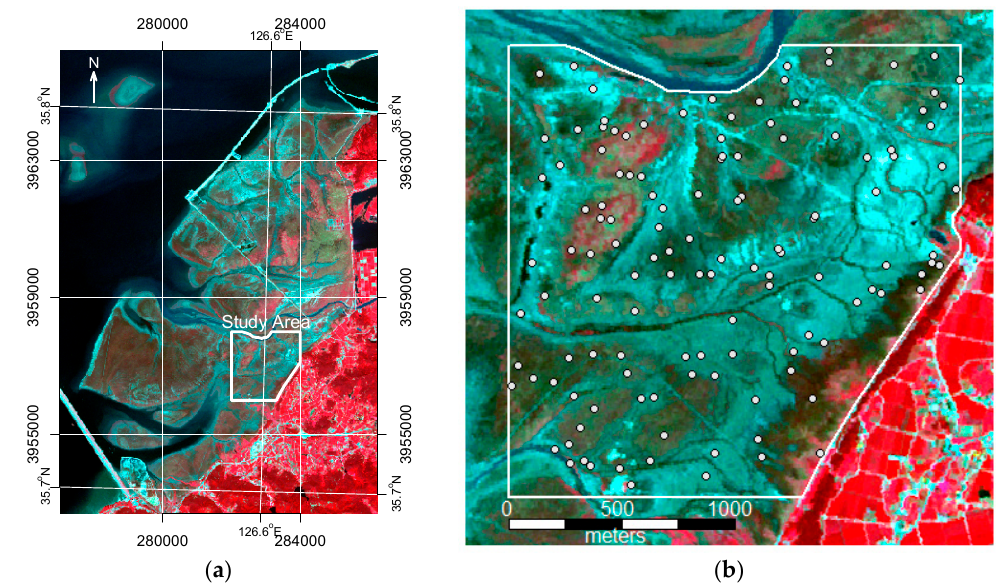
Figure 2. 1 September 2014, 5-3-2 RapidEye image of the study area; ( a ) southern part of the Saemangeum; ( b ) study area and 127 randomly selected sample points.